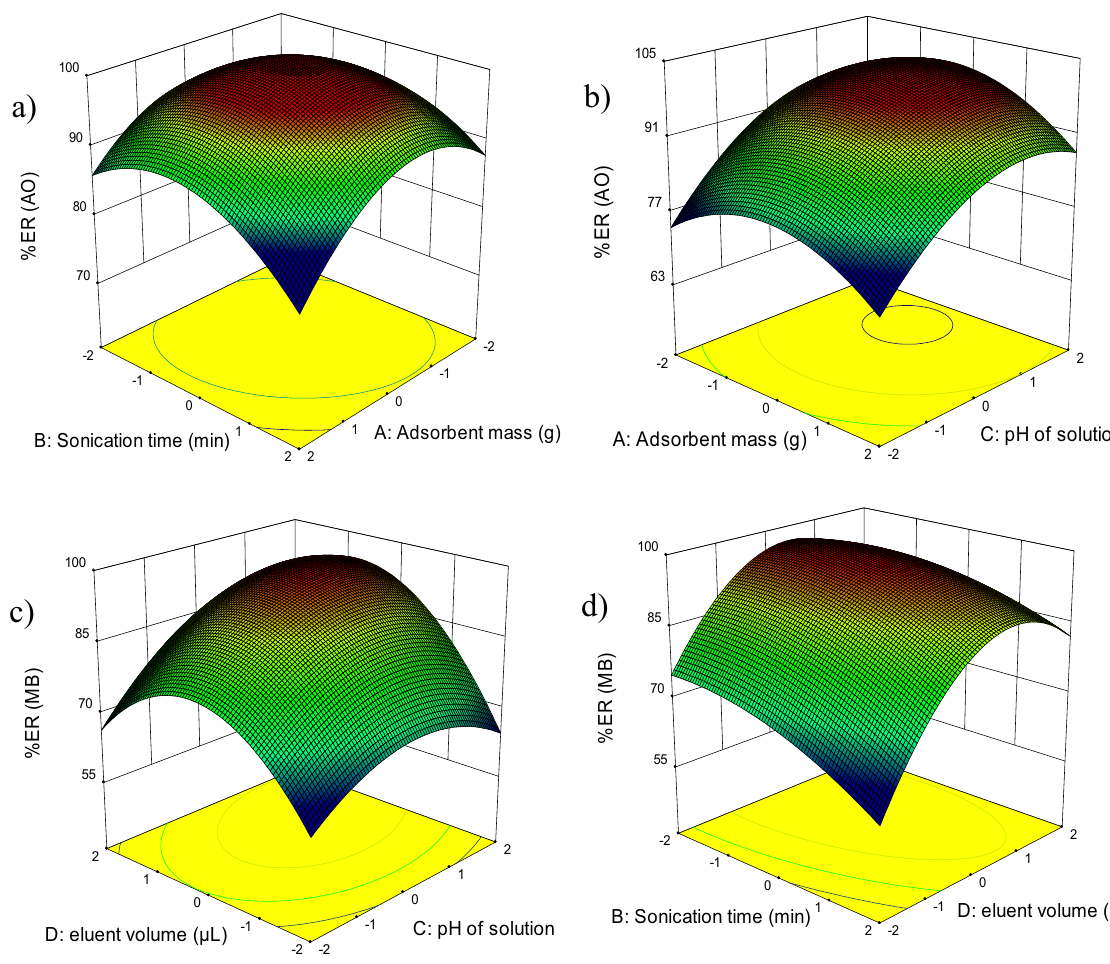
Figure 5. Three-dimensional plots of the interaction effects between variables and extraction efficiency of ( a ), ( b ) AO and ( c ), ( d ) MB (Image is created by using Design-Expert software version 10).